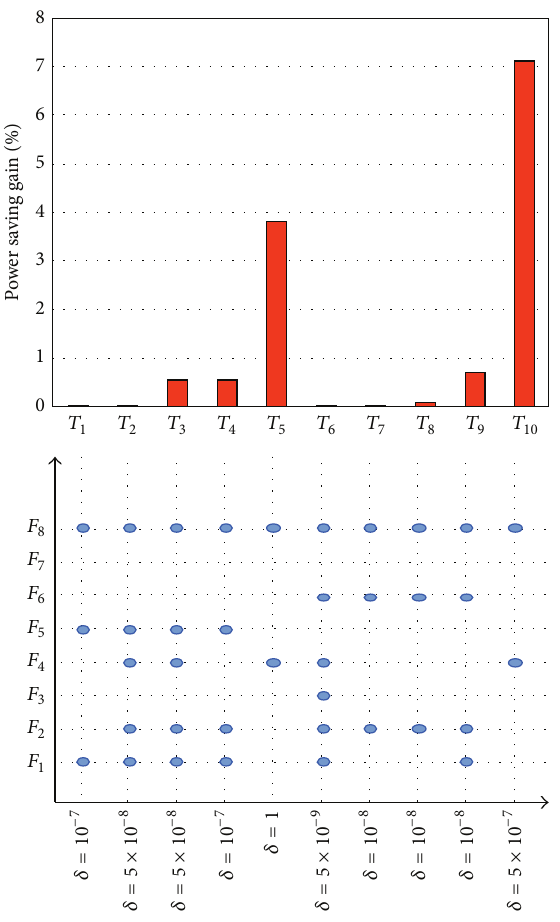
Figure 7: Power saving and selected configuration (𝛿,Φ) corre- sponding to a target loss probability of 10 −6 .